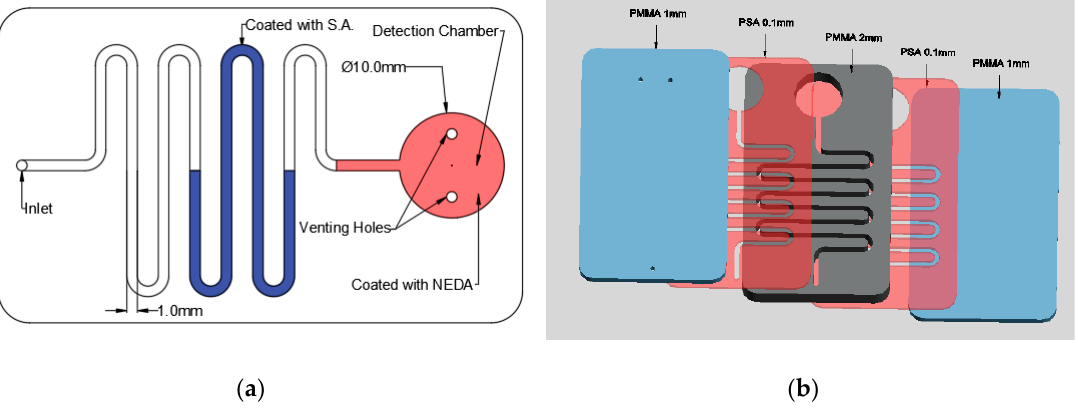
Figure 2. Nitrite detection microfluidic chip: ( a ) chip design and ( b ) the layers of the microfluidic chip.